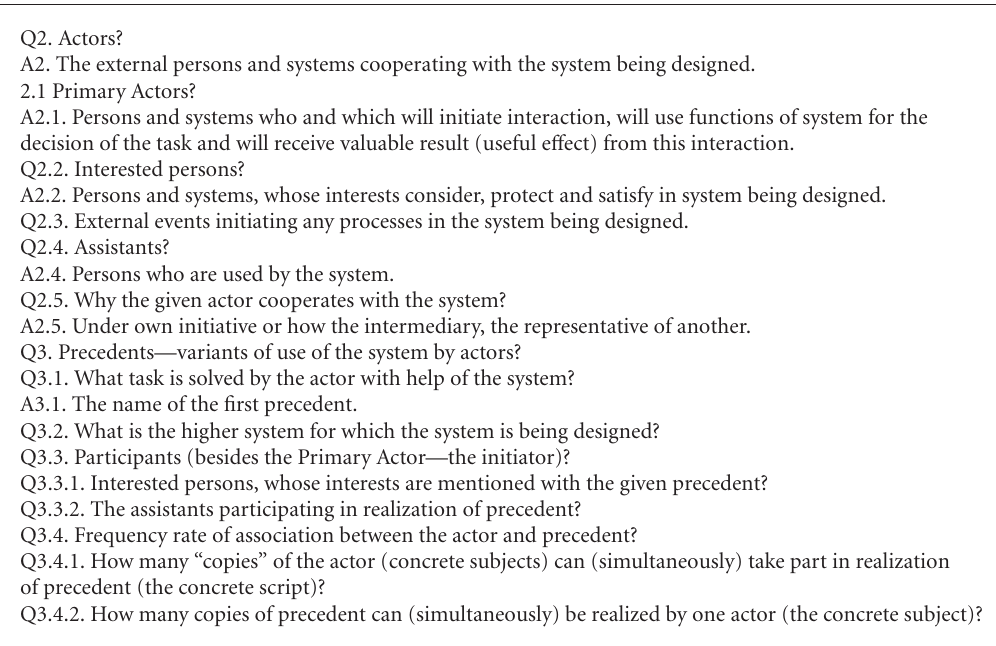
Algorithm 1: Fragment of QA-program for creation of Use-Case.